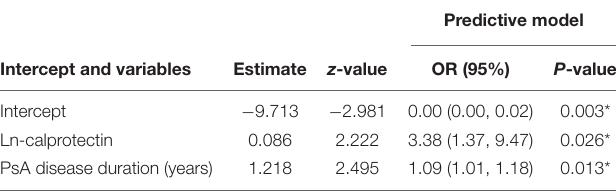
TABLE 2 | The logistic regression analysis of variables selected by LASSO regression for predicting the presence of carotid